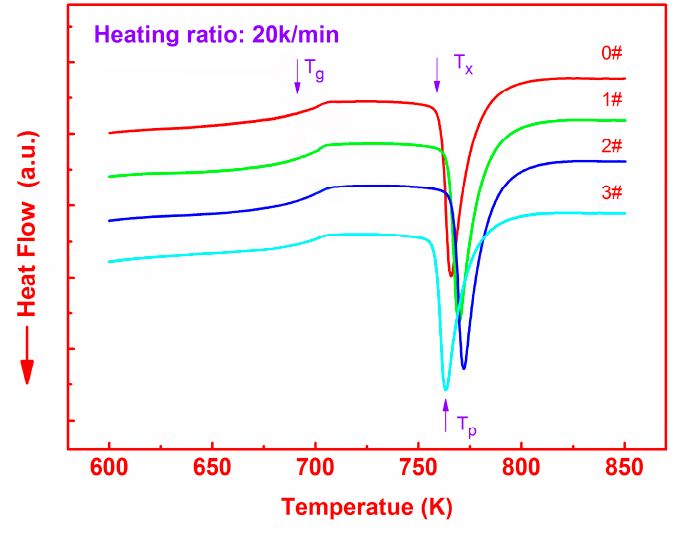
Figure 3. Differential scanning calorimetry (DSC) curves for the BMG matrix and welds processed with different currents. Table 1. Characteristic parameters for thermodynamics of the BMG matrix and three welds.